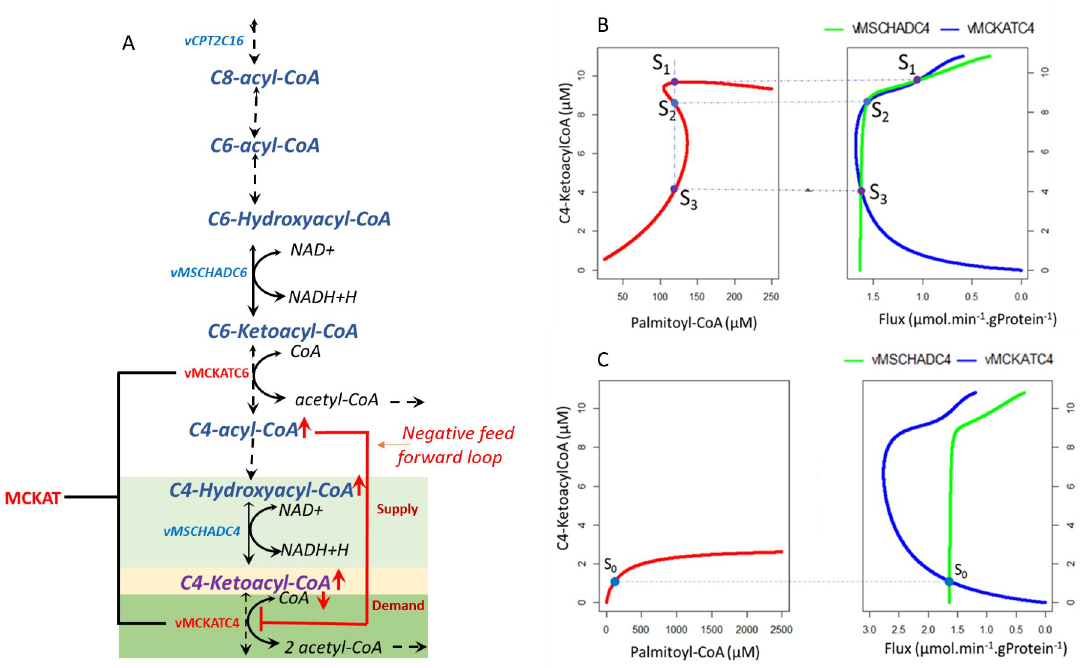
Fig 4. Origin of mFAO bistability. A. Modularisation of the mFAO pathway around C4-ketoacyl-CoA into a supply and a demand module. The flux of the supply and the demand module were plotted as a function of a fixed C4-ketoacyl-CoA concentration (B,C). B. Bistability of mFAO arises due to the presence of feedforward substrate inhibition (negative feedforward loop) of C4-acyl-CoA on vMCKATC4 (reaction rate of MCKAT for its C4 substrate) as shown by three steady states of mFAO (S1, S2, and S3) that correspond to three points of intersection between the rates vMCKATC4 and vMSCHADC4 (reaction rate of MSCHAD for its C4 substrate) around C4-ketoacyl-CoA. C. No bistability, but a single steady state as a result of removing the feedforward substrate inhibition (negative feedforward loop) of C4-acyl-CoA from vMCKATC4, corresponding to one point of intersection between the rates vMCKATC4 and vMSCHADC4. All calculations were done at a fixed concentration of 120 μ M palmitoyl-CoA.